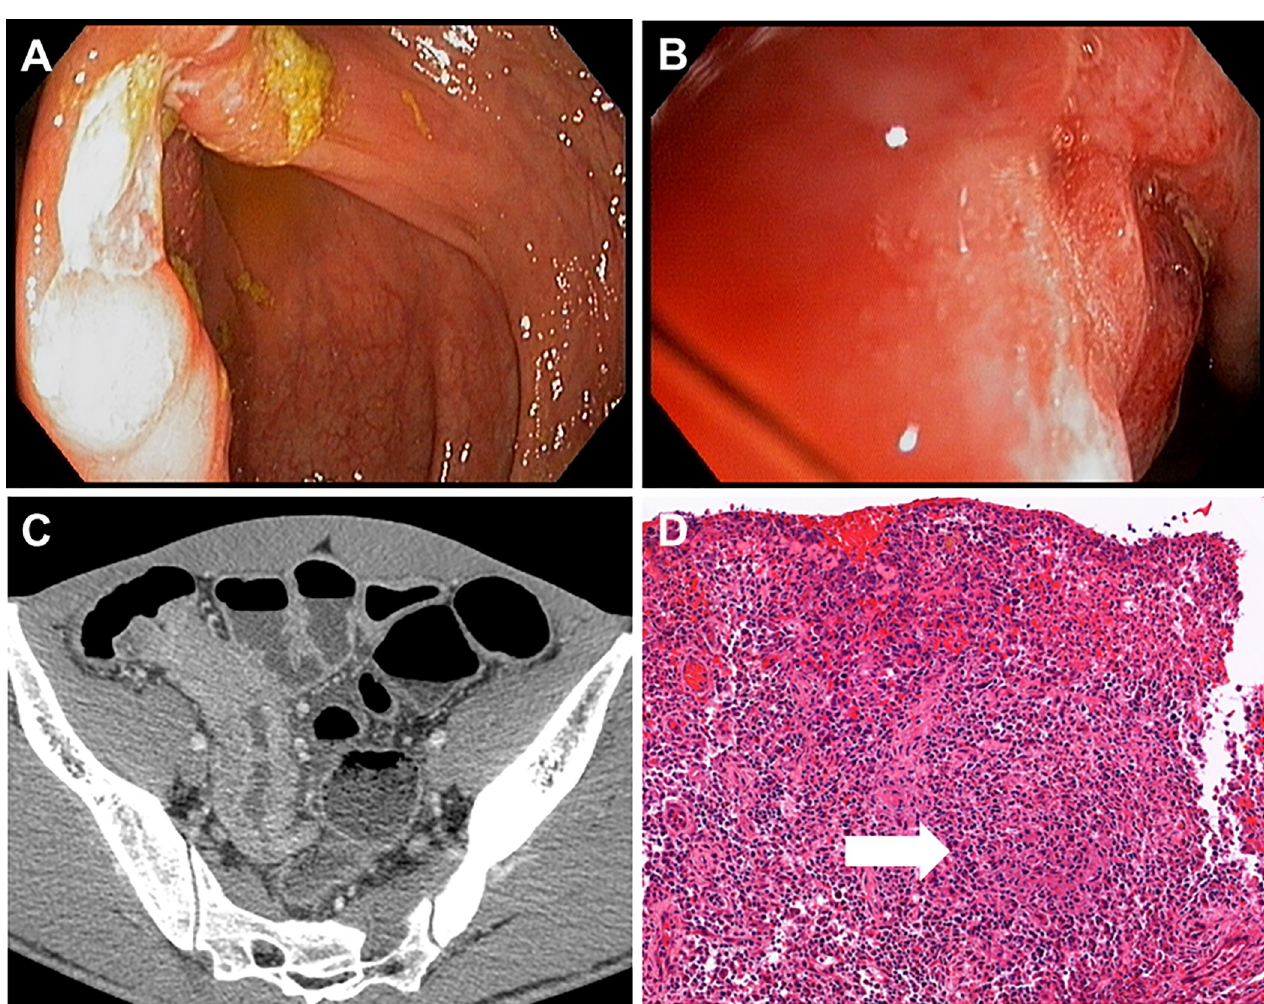
Fig 1. Endoscopic (A and B), computed tomography (C), and pathological findings (D) from the patient with intestinal tuberculosis. A and B showed a large ulcer involving the IC valve. C was an axial contrast-enhanced CT scan showing moderate segmental wall thickening with increased mucosal and mural enhancement at the terminal ileum with associated increasing IC valve thickness. D showed ulcerated ileal mucosa with dense chronic inflammatory cell infiltration and aggregates of epithelioid histiocytes (granuloma) with central necrosis